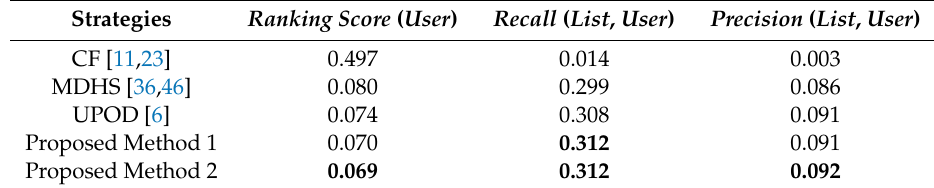
Table 1. Comparison of µ for the proposed methods with existing strategies— MovieLens .